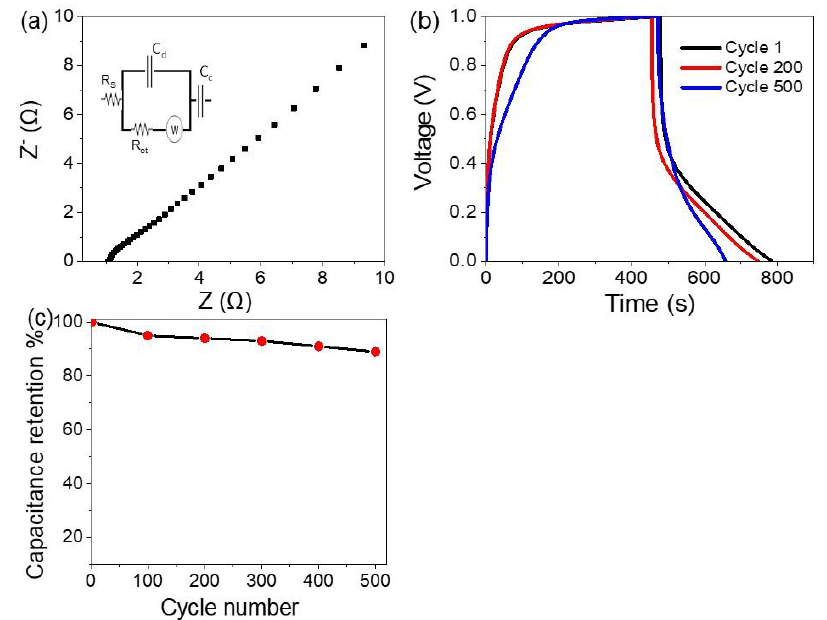
Figure 5. ( a ) The impedance ( b ) stability, ( c ) capacitance retention of the prepared supercapacitor.